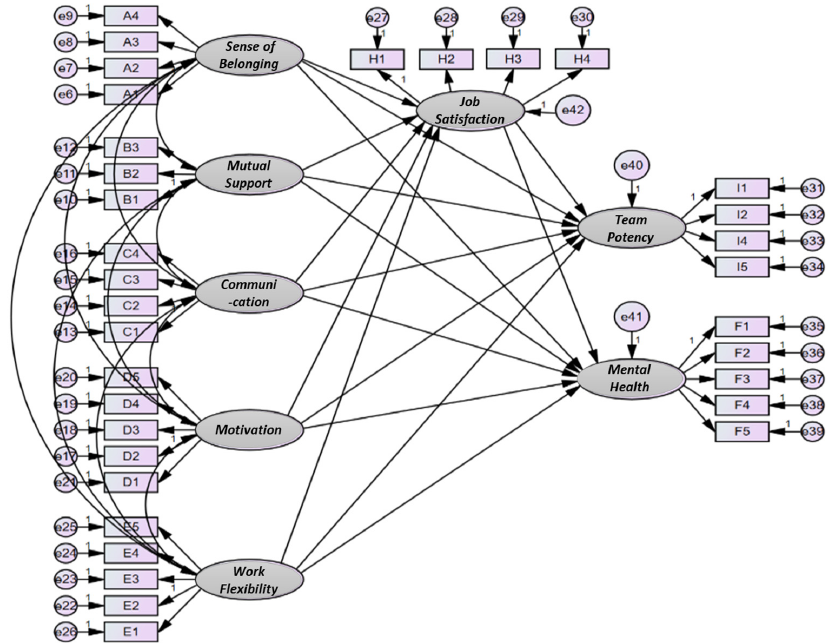
Figure 4. Structural equation model.